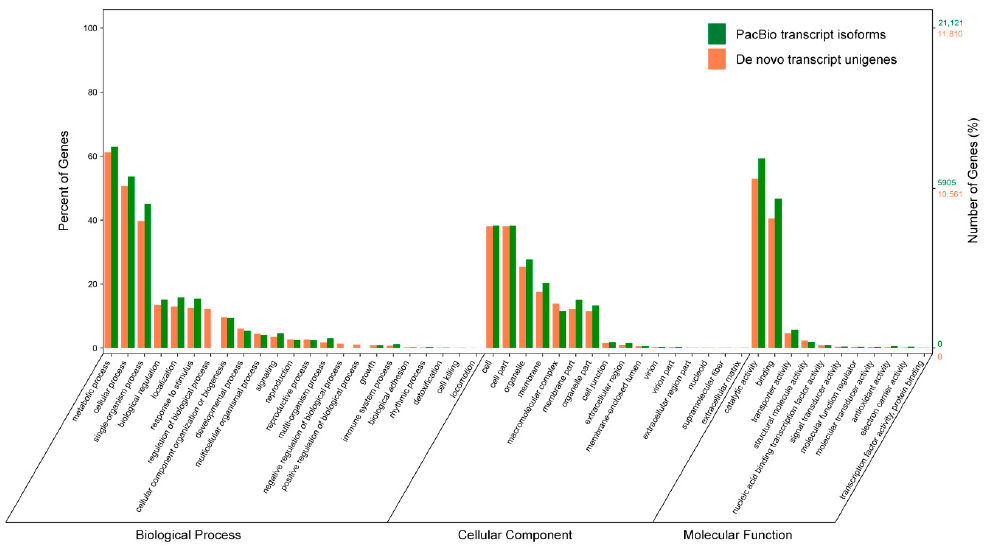
Figure 9. Gene ontology enrichment analysis of M. pasquieri transcript sequences.